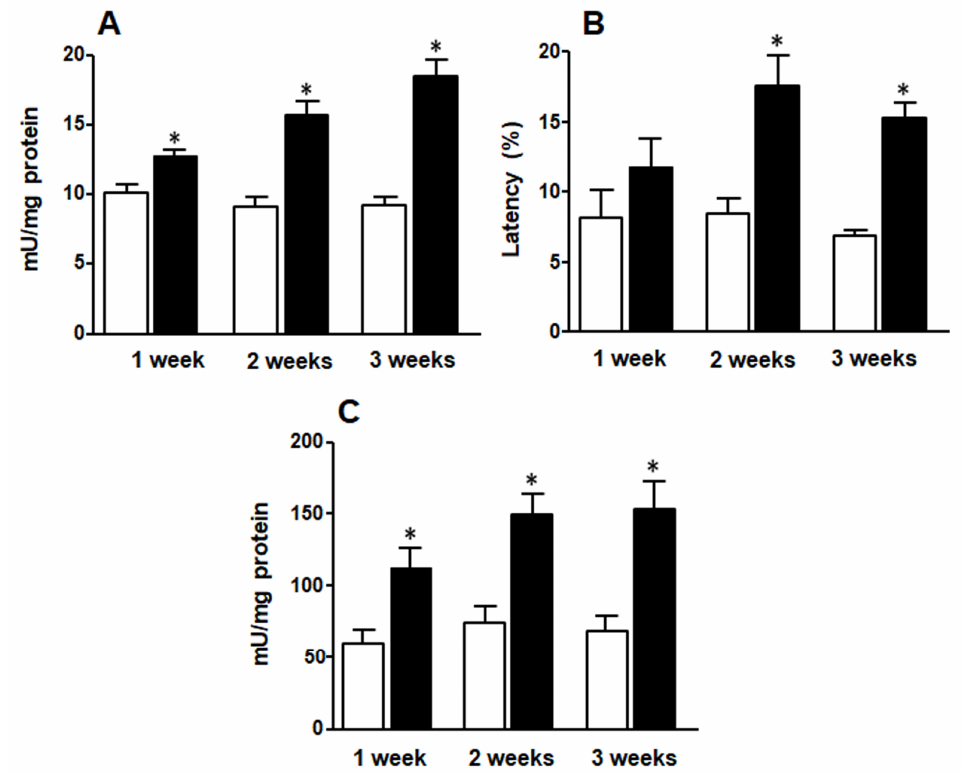
Figure 4. Liver glucokinase ( A ), G6P-DH ( B ) and G6Pase ( C ) activities. White bars: control group (C rats), black bars: rats fed FRD (F rats). Values are expressed as means ± SEM ( n = 12 rats per group) * p < 0.05 compared to each control at each time point.